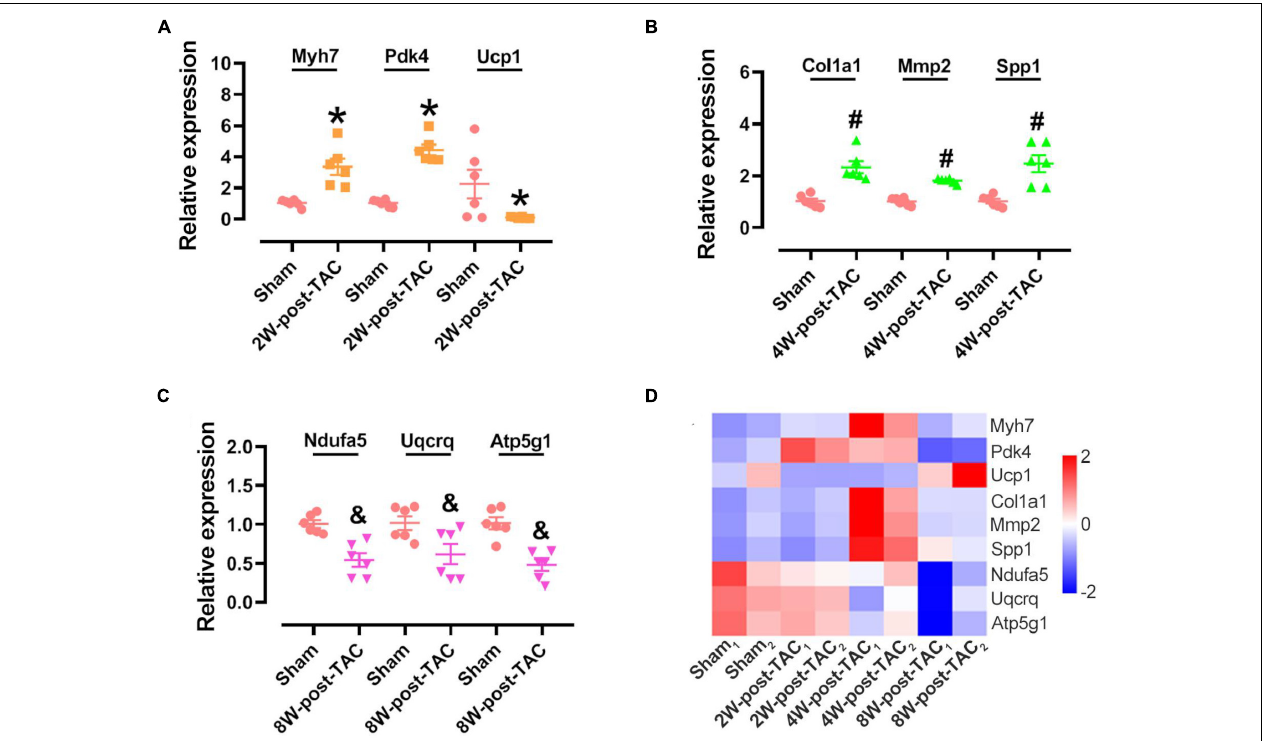
FIGURE 9 | Hub gene identification in the 2W-, 4W-, and 8W-post TAC hearts. Nine genes were randomly selected for verifying their expression in the 2W-post-TAC (A) , 4W-post-TAC (B) , or 8W-post-TAC stage (C) . N = 6. *, # , and & P < 0.05 vs. Sham. RNA sequencing profiles showed expression of these genes were dynamic in the three stages of heart failure (D) . N = 2 for the sham, 2W-, 4W-, and 8W-post-TAC groups. The color bar from blue to red, indicating expression levels from low to high.